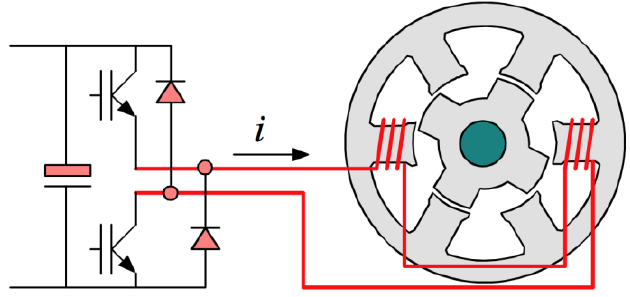
Fig. 2. Partial scheme for the Half Bridge